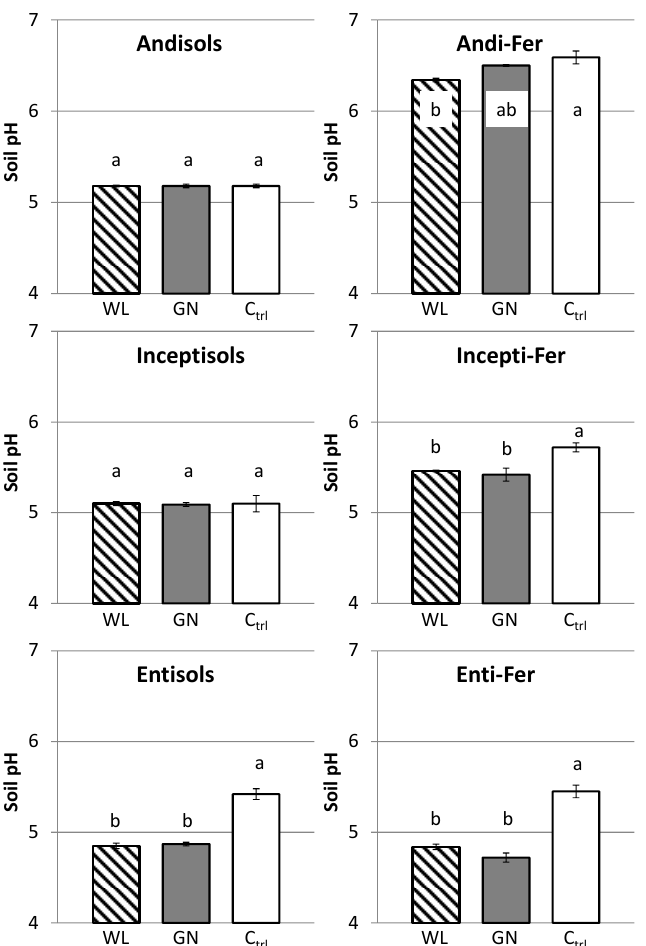
Figure 4. Soil pH of rhizosphere (WL and GN) and control (C trl ) soil after pot experiment; Bar indicates the standard error of mean ( n = 5); Different letter indicates the significant differences among WL, GN and C trl soil in each soil type, according to the Tukey test ( p < 0.05).